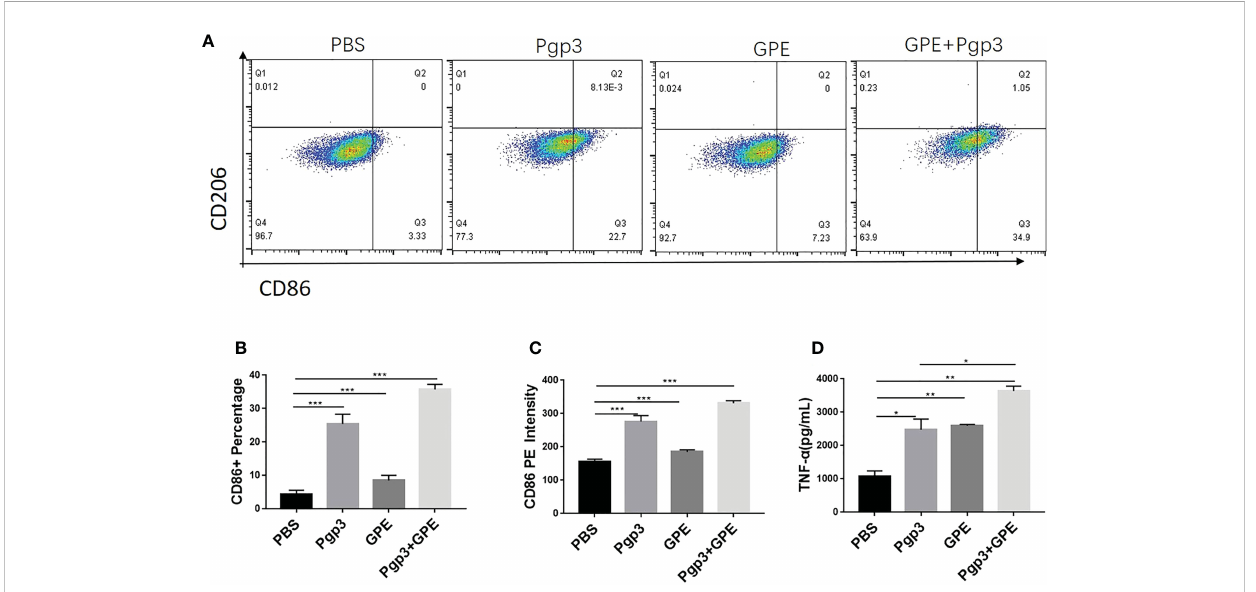
FIGURE 6 M1/M2 polarization of macrophages. (A) Representative fl ow cytometry dot plot analysis of macrophages treated by GPE and Pgp3; (B) statistical analysis fl ow cytometry dot plot of CD 86 + macrophage percentage; (C) statistical analysis of CD86-PE fl uorescence intensity; (D) TNF- a secreted by macrophages incubated for 48 h. ( n = 3). GPE, GO-stabilized Pickering emulsion; TNF- a , tumor necrosis factor